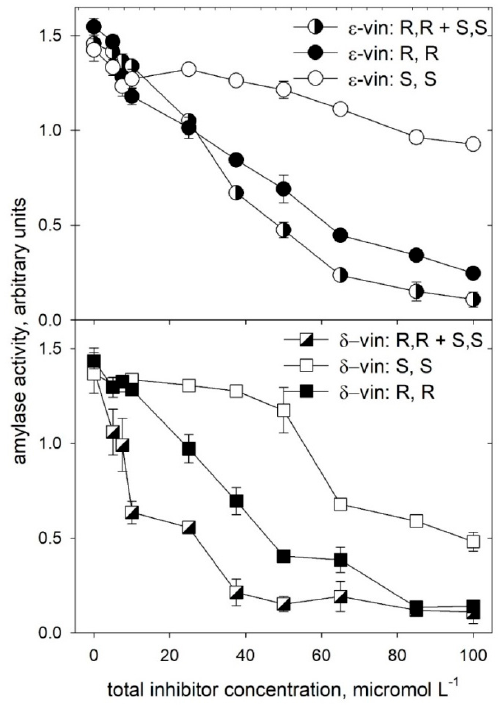
Figure 6. Concentration dependence of the α -amylase inhibition by purified enantiomeric forms of trans - δ -viniferin ( 5 ) and trans - ε -viniferin ( 6 ), and by equimolar mixtures of their purified enantiomers, simulating the presence of a racemic form of each